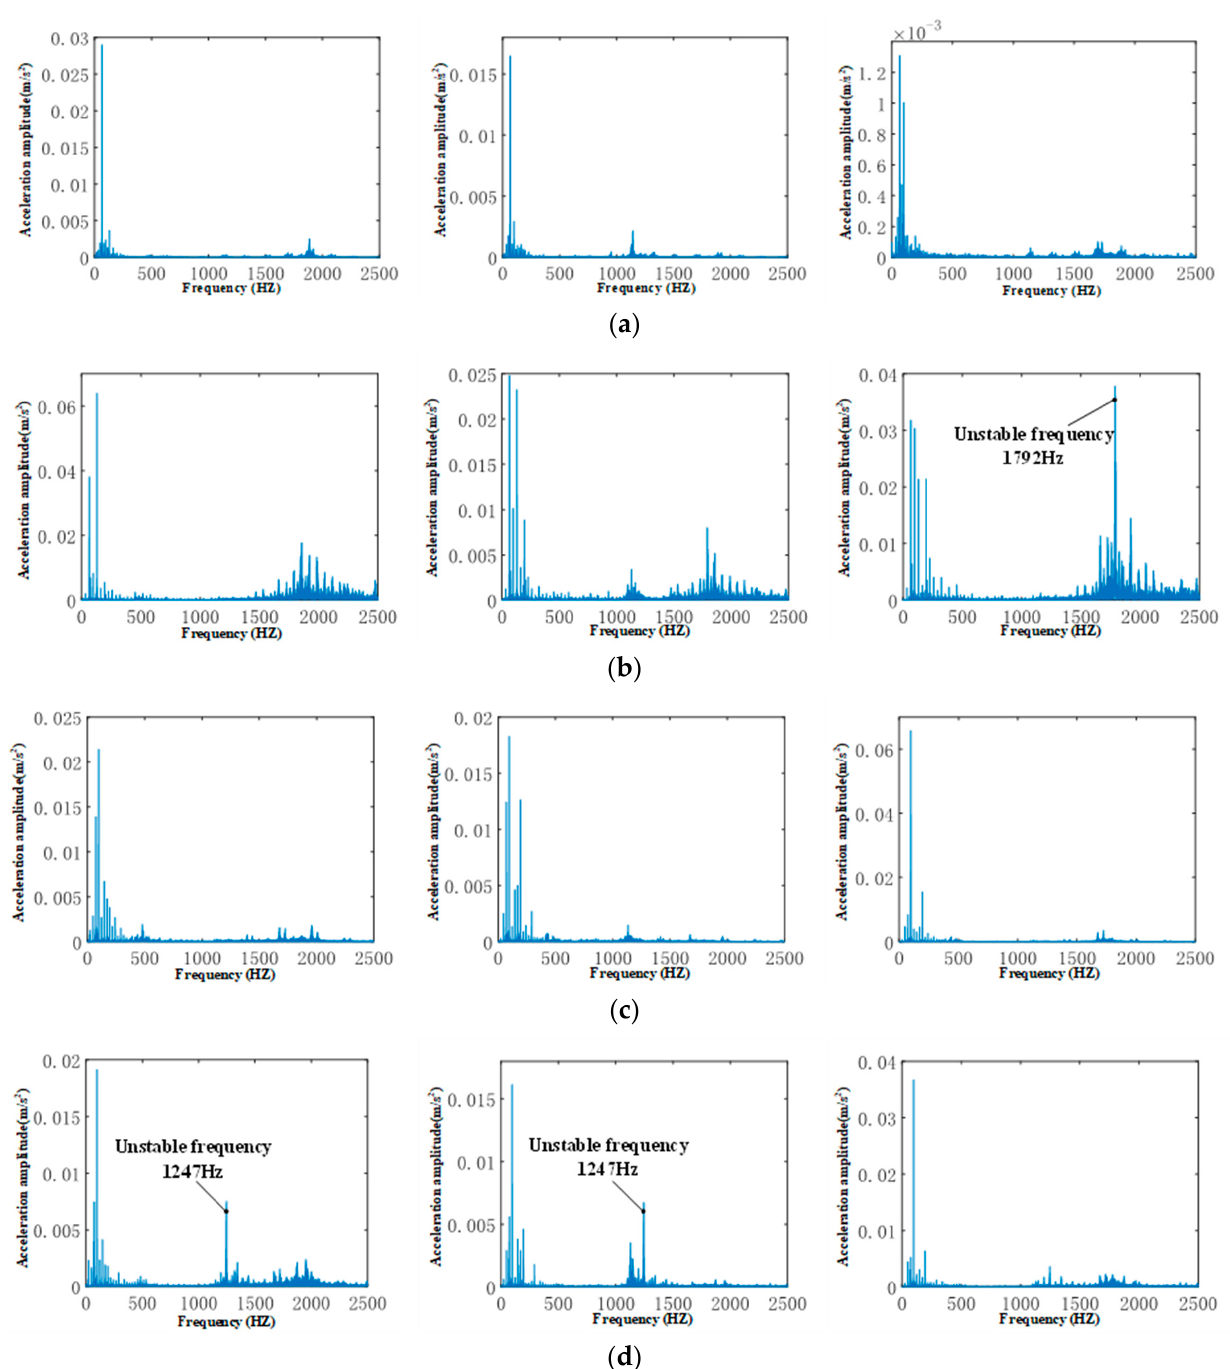
Figure 13. Spectrum of experimental acceleration signal. ( a ) Signal spectrum of acceleration along x, y and z under Position 1 (cutting parameter combine 1); ( b ) Signal spectrum of acceleration along x, y and z under Position 1 (cutting parameter combine 10); ( c ) Signal spectrum of acceleration along x, y and z under Position 2 (cutting parameter combine 1); and ( d ) Signal spectrum of acceleration along x, y and z under Position 2 (cutting parameter combine 10).